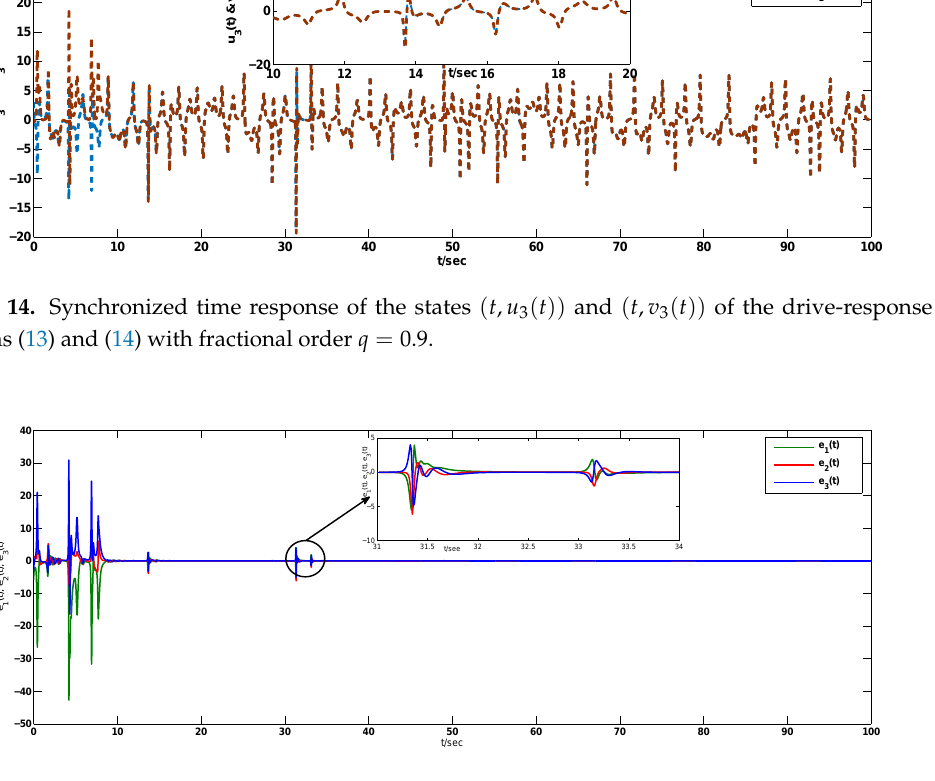
Figure 15. Time response of the states e 1 ( t ) , e 2 ( t ) , e 3 ( t ) for the error system (15) with fractional order q =